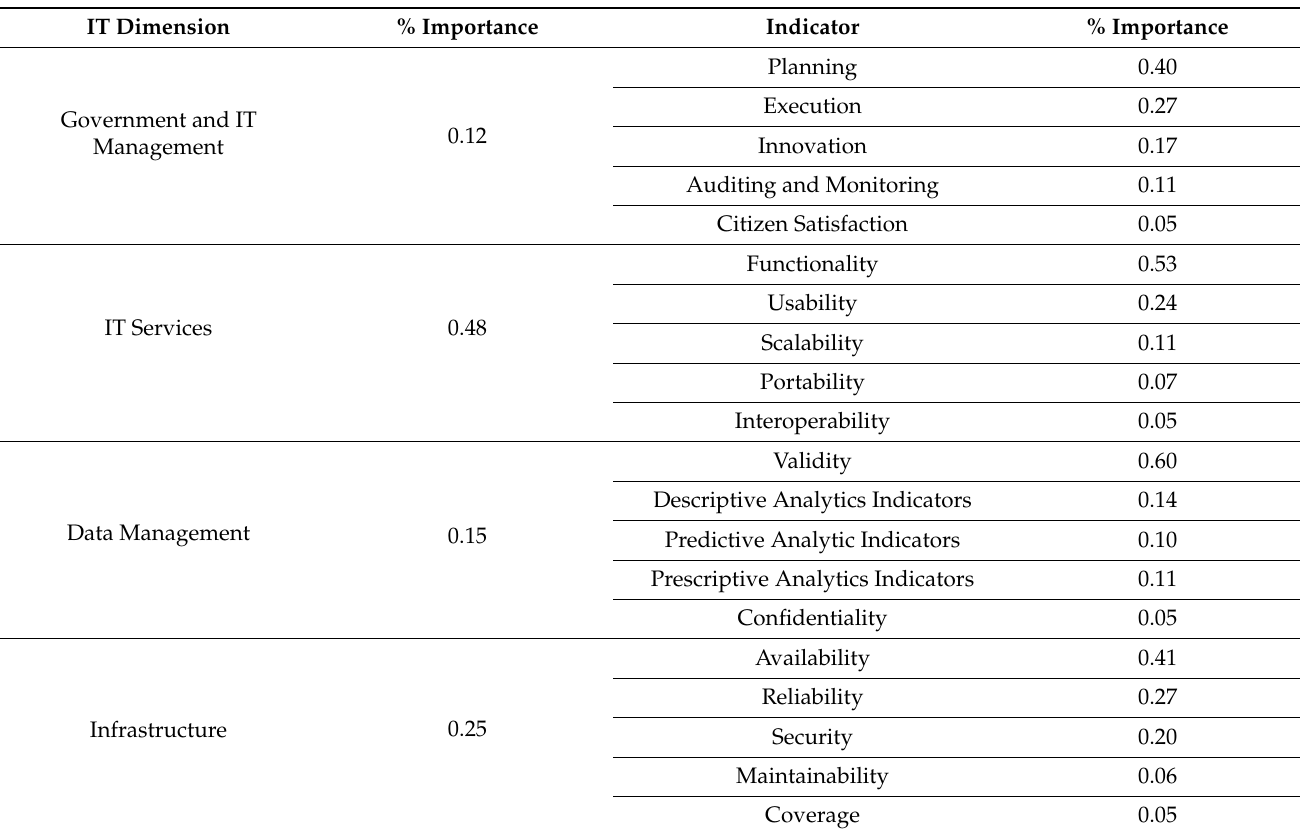
Table 10. Step 2c: Determine importance of